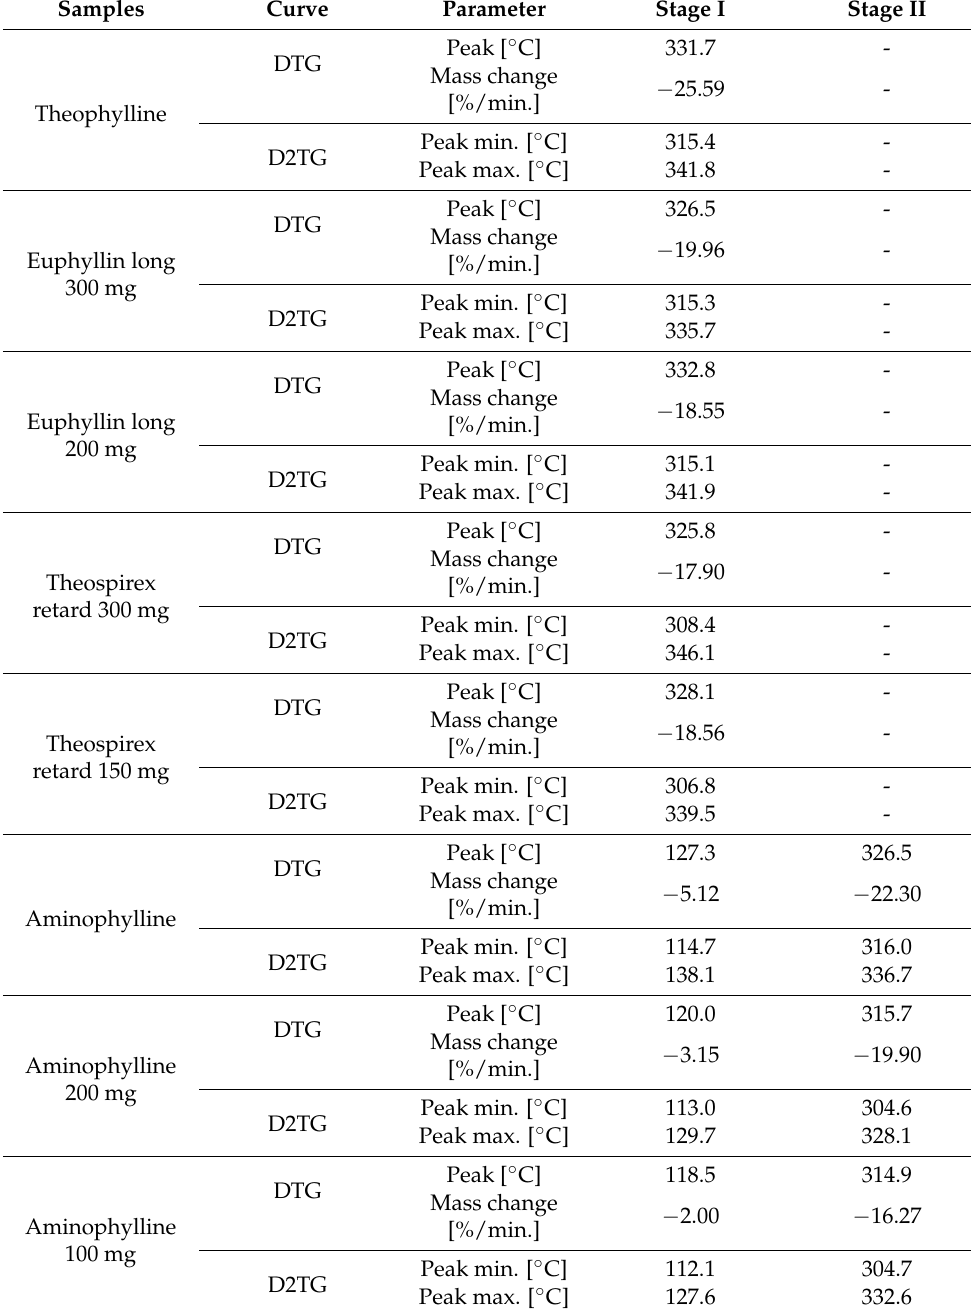
Table 2. The characteristic parameters of DTG, and D2TG curves of the tested